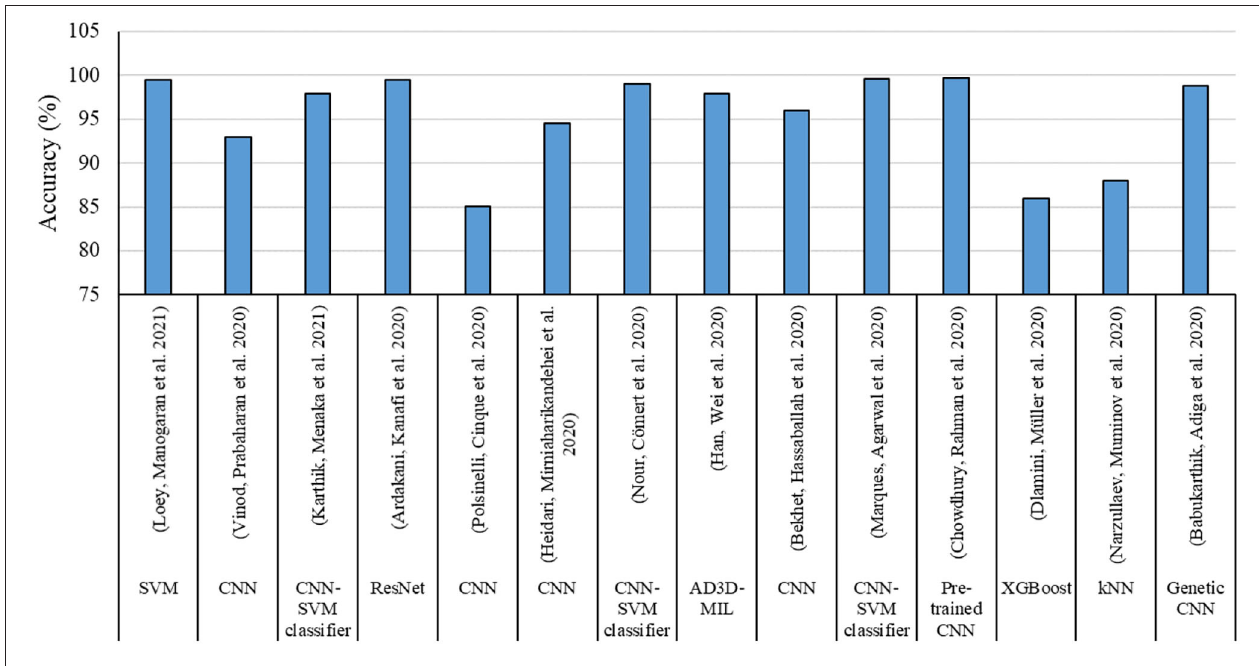
FIGURE 9 | Accuracy